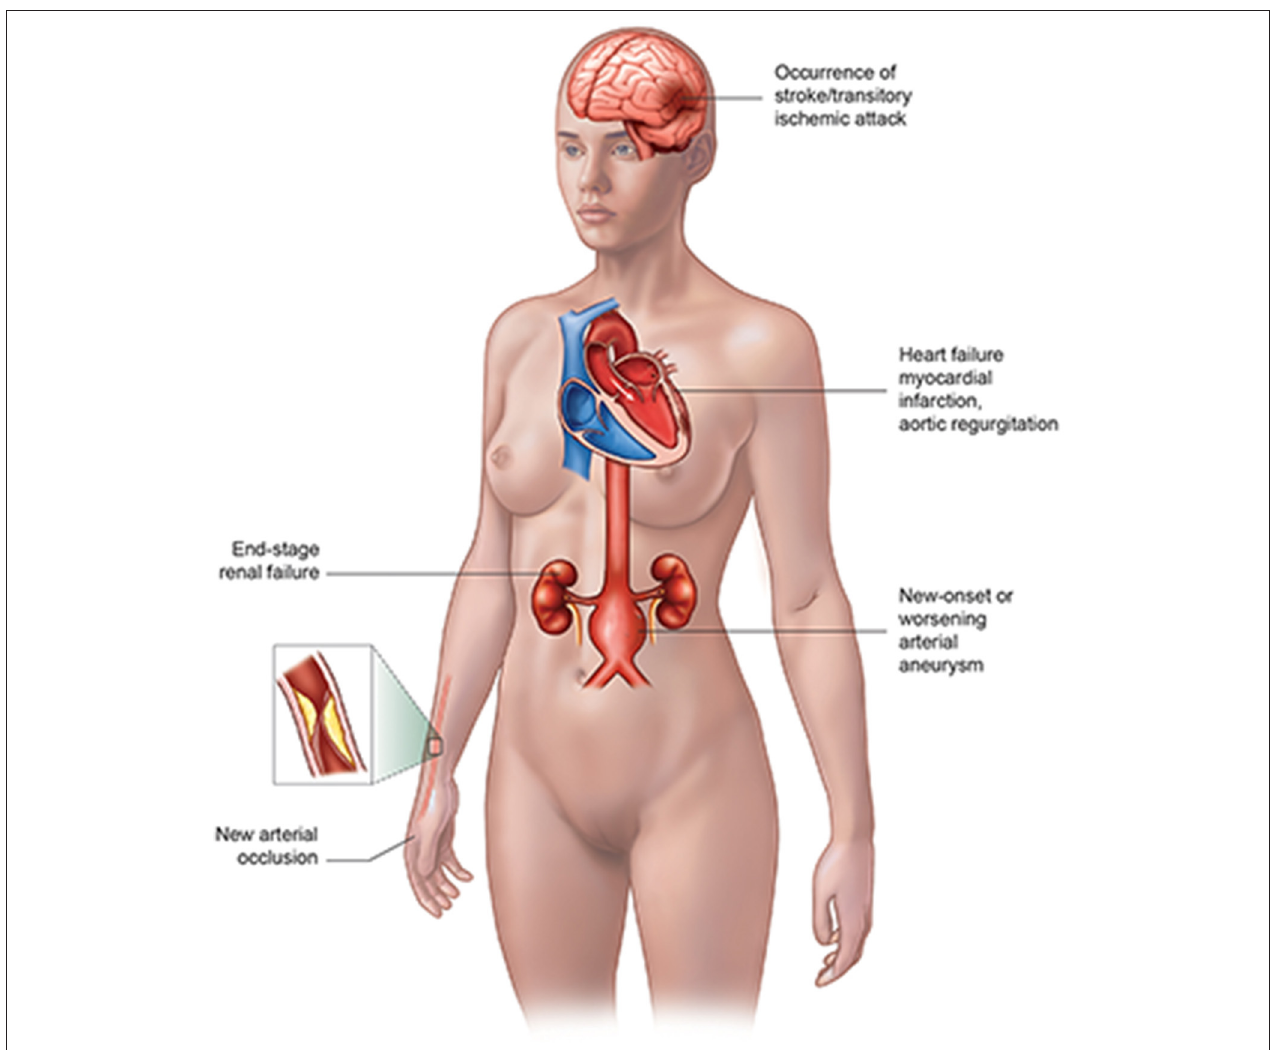
FIGURE 1 | The vascular complications of TA